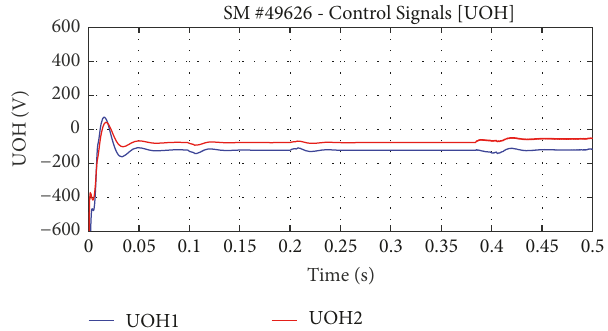
Figure 17: Sliding mode control signal (Shot #49626).